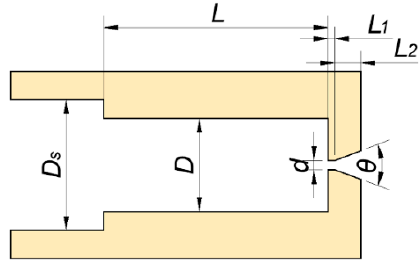
Figure 1. Schematic diagram of experimental setup for the submerged cavitation jet.